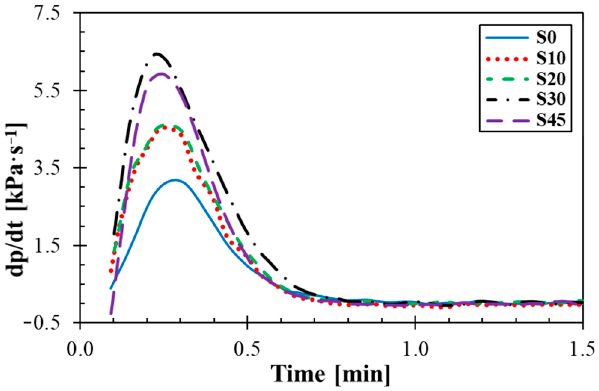
Figure 3. Time dependencies of rate of blowing.